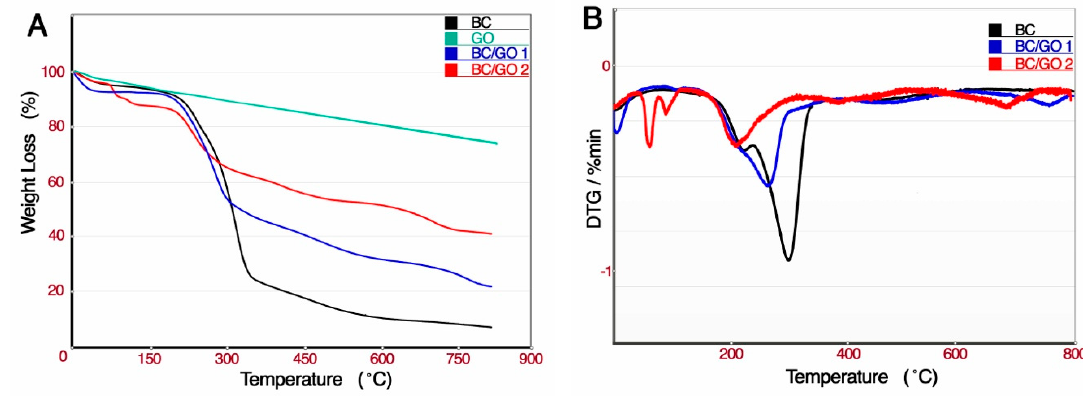
Figure 3. TGA analysis of prepared samples.